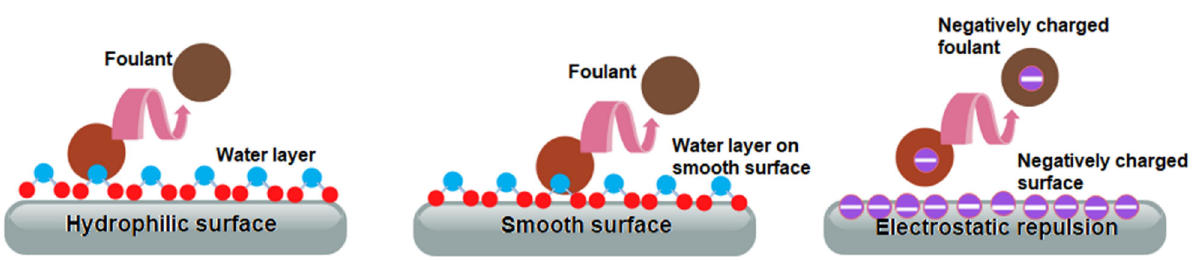
Figure 2. Illustration of membrane surface properties and antifouling